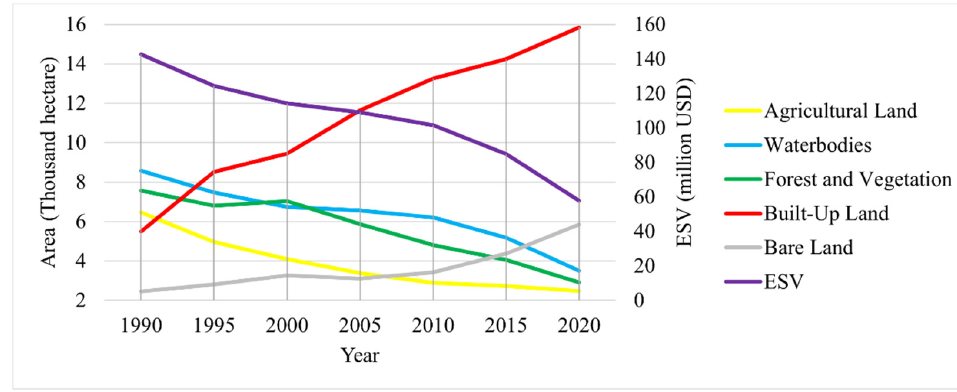
Figure 8. Relationship between ESV and LULC change.